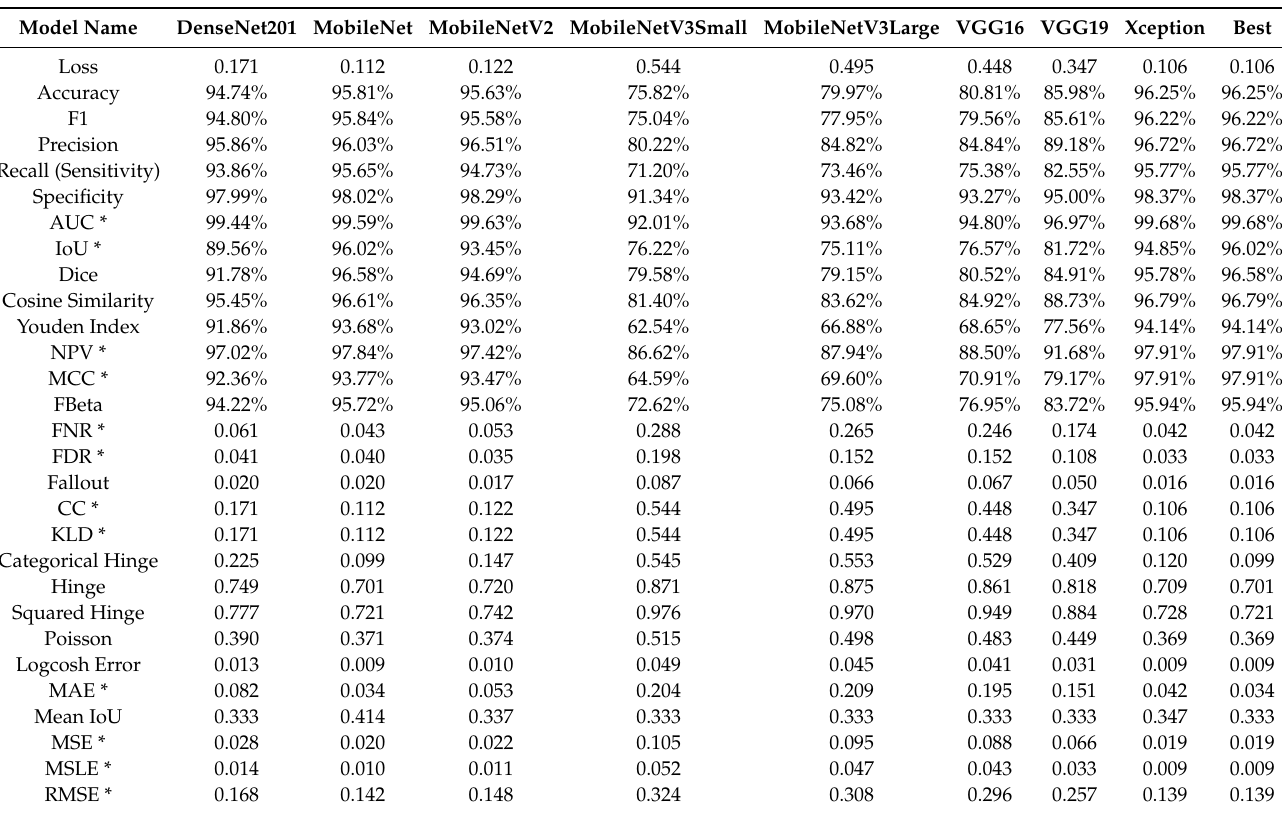
Table 7. The best performance metrics reported by the “Alzheimer’s Disease Neuroimaging Initiative (ADNI)”